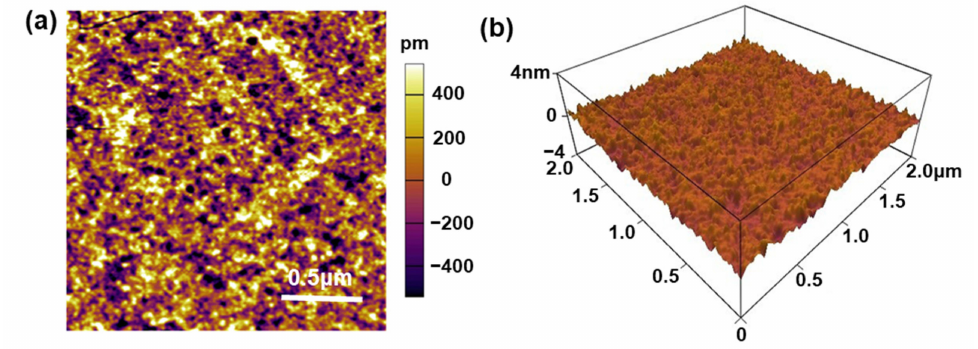
Figure 4. ( a ) Representative AFM topography image and ( b ) corresponding 3D surface plot of the LiNbO 3